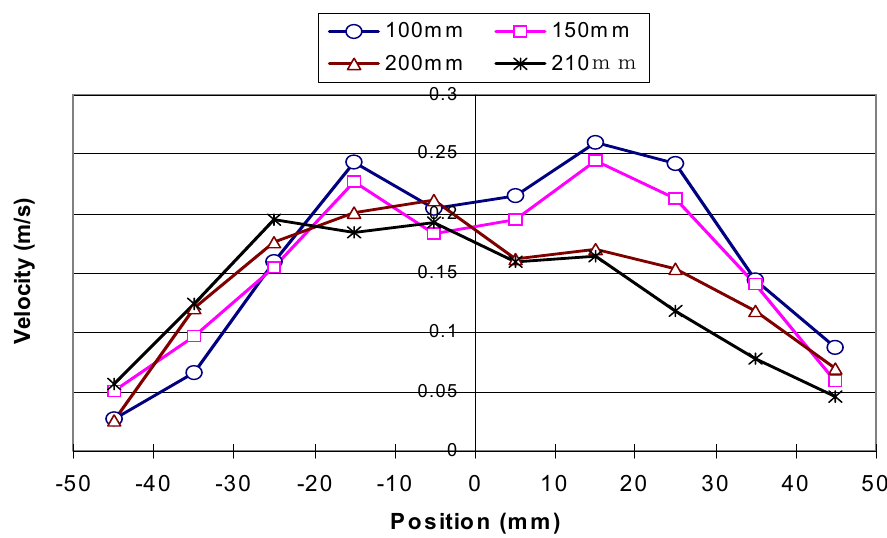
Fig. 12 : X-direction velocity for 0-degree and with fire-tube conditions